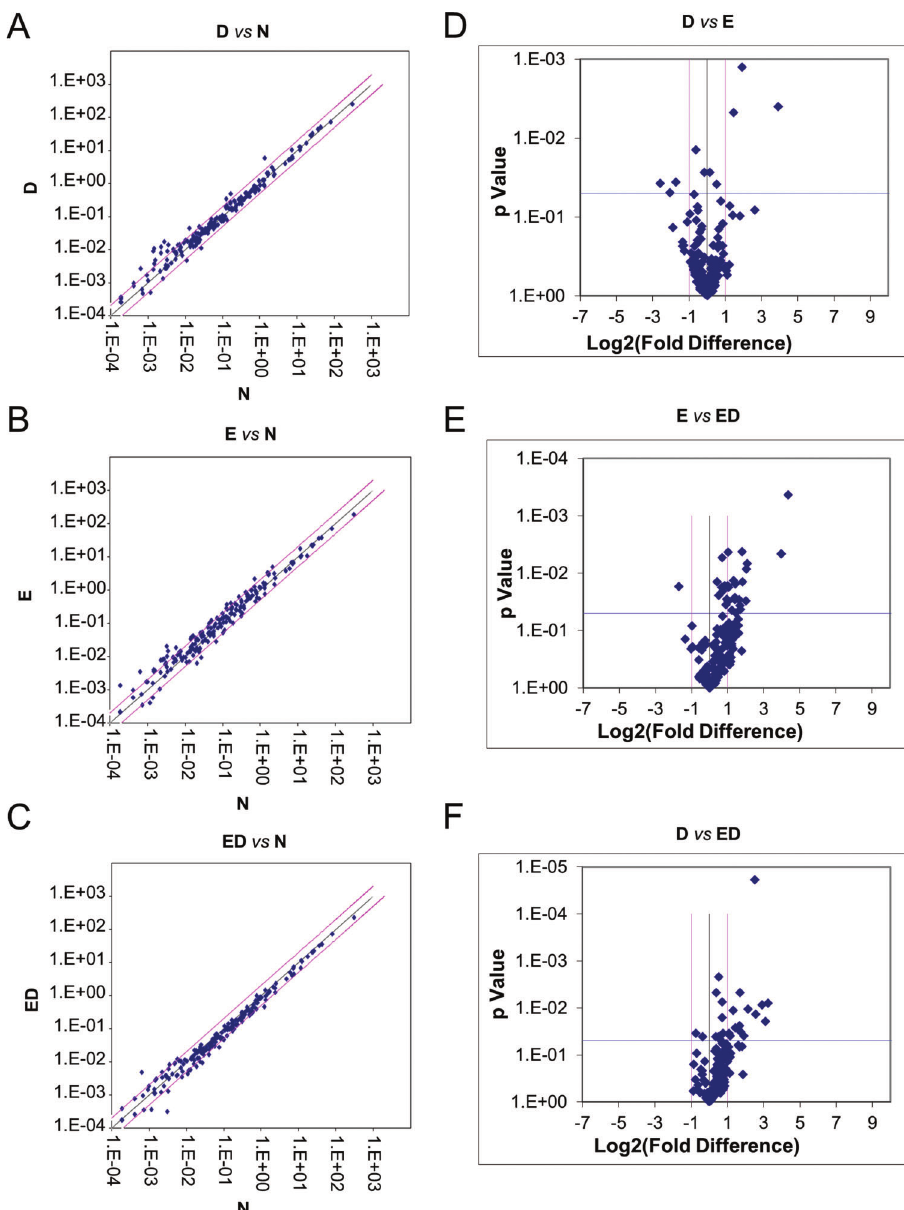
Figure S2 - Comparation of plasma miRNA expression profiling among patients and healthy donors. A-C Scatter plot illustration of serum miRNAs between the D and N groups ( A ), E and N groups ( B ), and ED and N groups ( C ). D-F Scatter plot illustration of serum miRNAs between the D and E groups ( D ), E and ED groups ( E ), and D and ED groups ( F ).